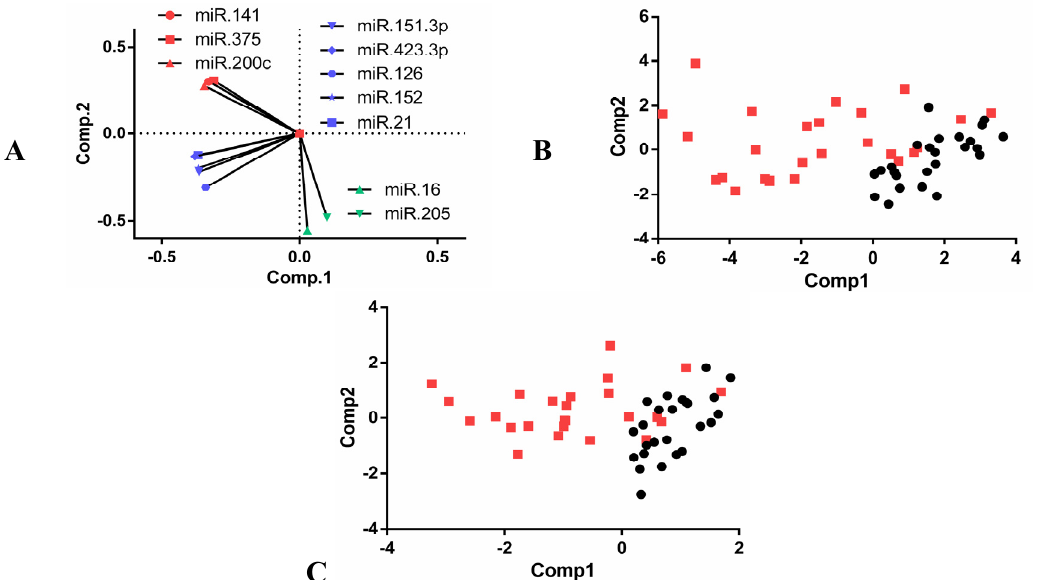
Figure 3. Principle Component Analysis (PCA) on the ten validated differentially expressed miRNAs. ( A ) Visual representation of the highly correlated pattern observed in the Pearson’s correlation; ( B ) PCA using all 10 miRNAs is able to distinguish localized PCa from mCRPC; although ( C ) PCA using a combination of only miR-141 + miR-151-3p + miR-16 shows a similar ability to separate the two